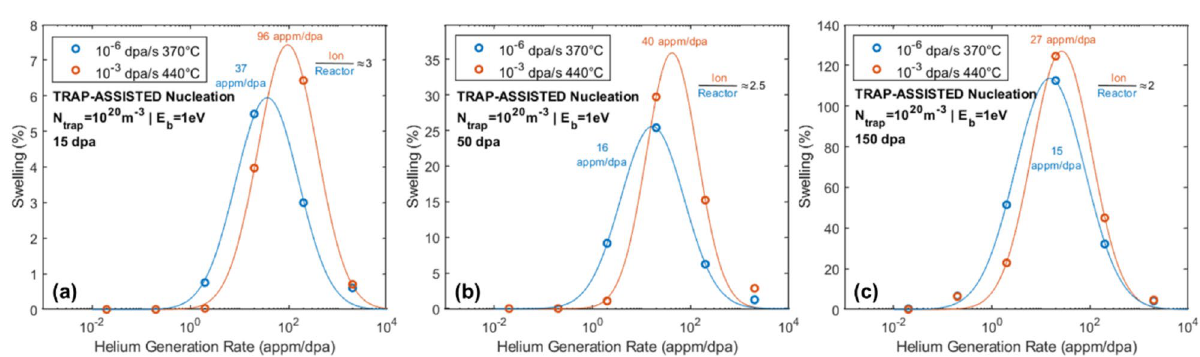
Figure 7. Swelling at ( a ) 15 dpa, ( b ) 50 dpa, and ( c ) 150 dpa as a function of helium co-injection rate for ion (10 −3 dpa/s) and fast reactor (10 –6 dpa/s) dose rates with helium traps with E b = 1 eV and density of 10 20 m -3 resulted in nearly identical cavity microstructures across the five conditions examined, as shown in Fig. 1. At low temperatures (376 °C in reactor and 445 °C with ions), both modes of the bimodal cavity distribution were